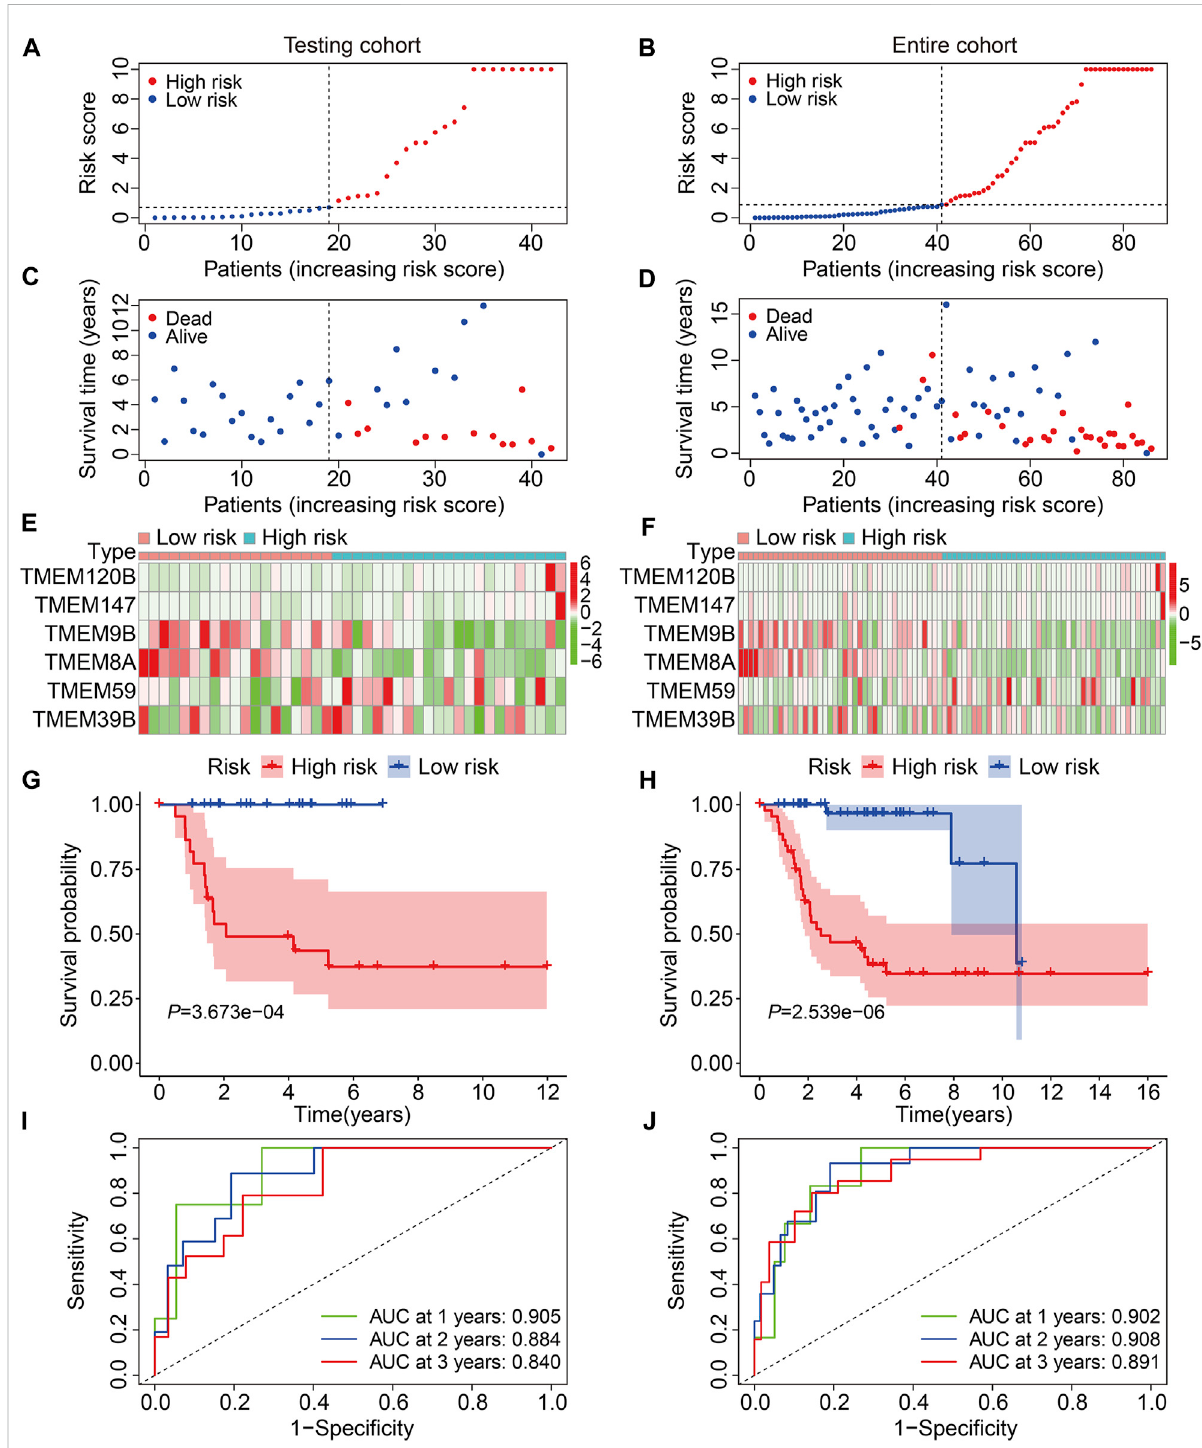
FIGURE 3 Validation of the TMEM protein family gene-based signature in internal cohorts. (A,B) Distribution of risk scores of patients in the testing and entire cohorts. (C,D) distribution of survival time and survival status of patients in the testing and entire cohorts. (E,F) Expression pro fi les of the six genes in the testing and entire cohorts. (G,H) Kaplan – Meier survival analysis for the comparison of the overall survival between the high- and the low-risk group. (I,J) Time-dependent ROC curve for 1-, 2-, and 3-year overall survival in the testing and entire